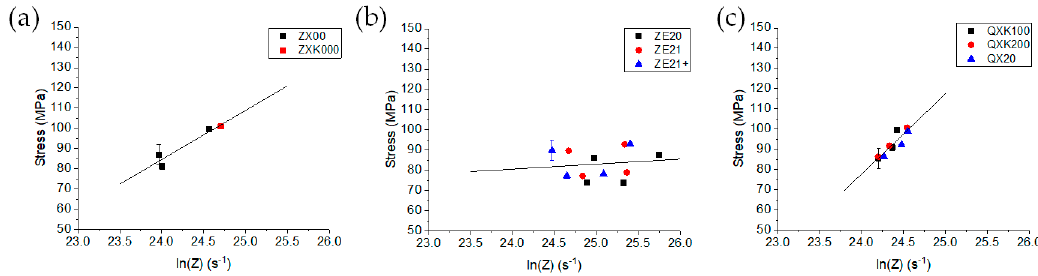
Figure 9. Steady state extrusion stress vs. a temperature compensated strain rate Z for the three alloy series; lines from linear regression are to guide the eyes: ( a ) ZX-series alloys, ( b ) ZE-series alloys, and ( c ) QX-series alloys.